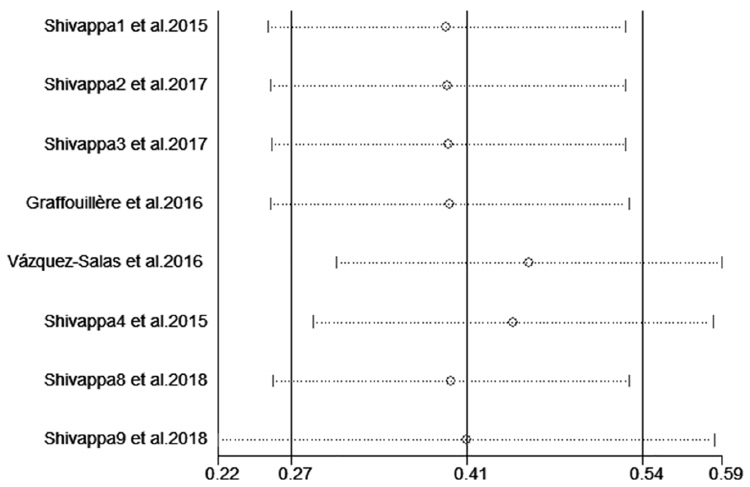
Fig 4. Sensitivity analysis diagram for each study used to assess the association between the DII score and prostate cancer risk.